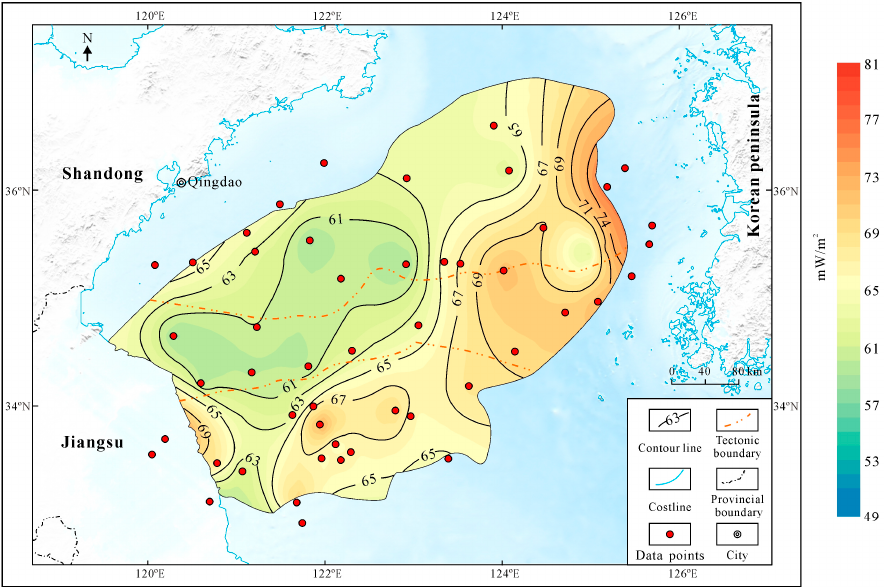
Figure 5. Terrestrial heat flow map of Cenozoic strata in the South Yellow Sea Basin (terrestrial heat flow data from the International Heat Flow Commission